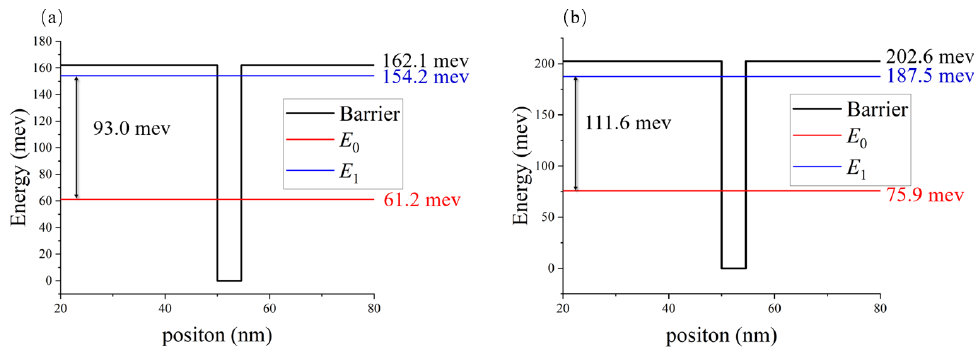
Figure 2. Energy level diagram inside a quantum well: ( a ) quantum well energy level operating at a wavelength of 13.2 µ m (QW1) and ( b ) quantum well energy level operating at a wavelength of 11.0 μm (QW2).